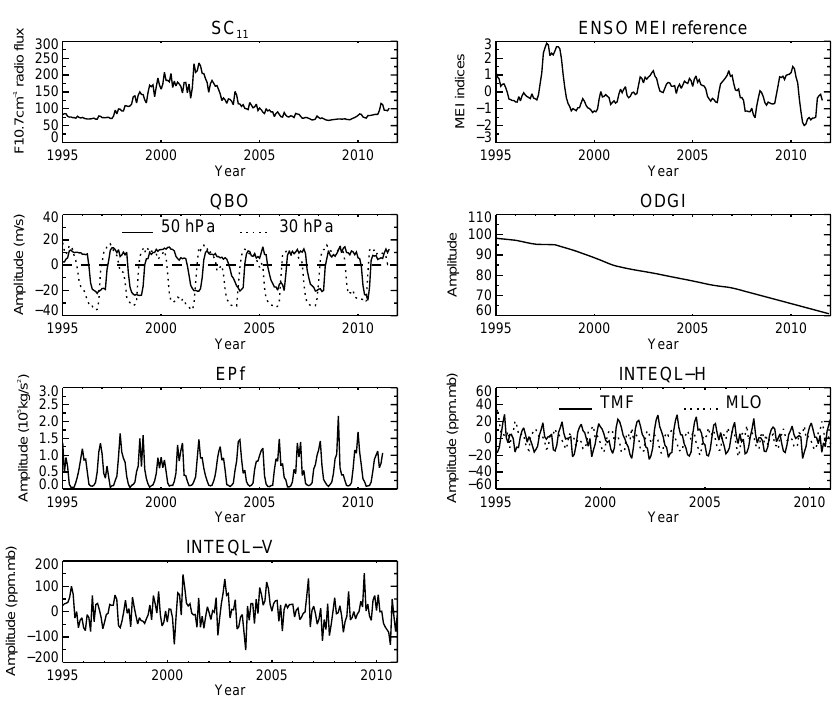
Fig. 4. Proxies used in the model for both stations. For EPf and INTEQL-V, the plots represent the proxy used for TMF.